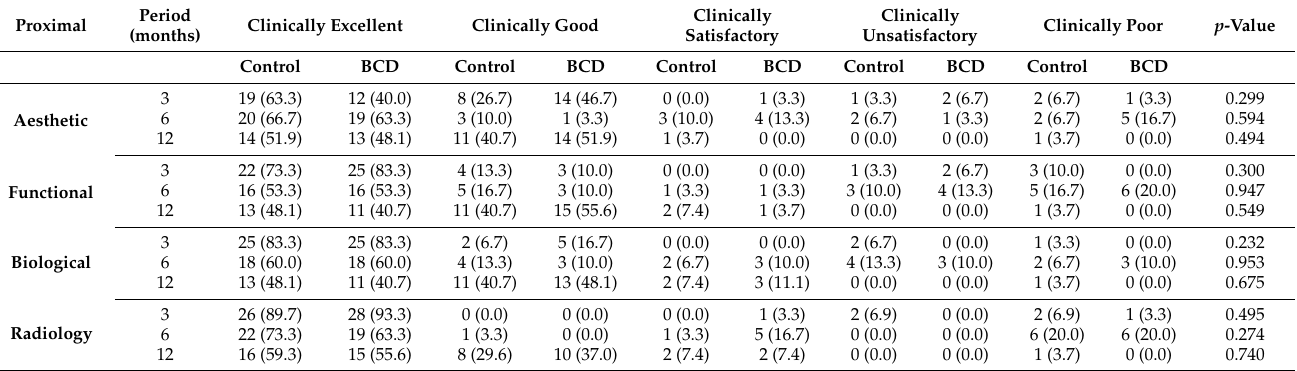
Table 4. Aesthetic, functional, biological, and radiological post-operative evaluation at 3, 6, and 12 months among the groups (Proximal